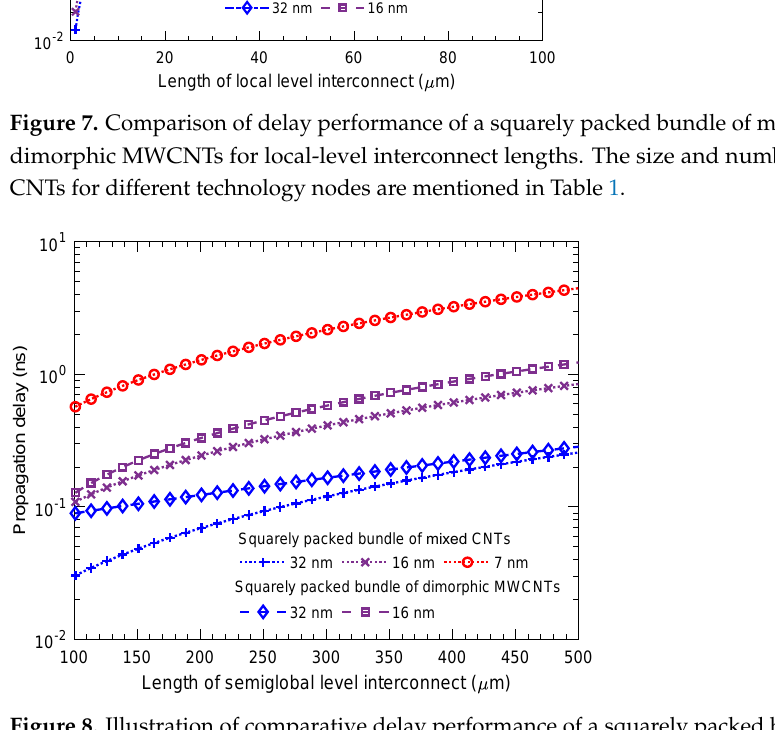
Figure 8. Illustration of comparative delay performance of a squarely packed bundle of mixed CNTs and that of dimorphic MWCNTs for semiglobal-level interconnect lengths. The size and number of accommodated CNTs for different technology nodes are mentioned in Table